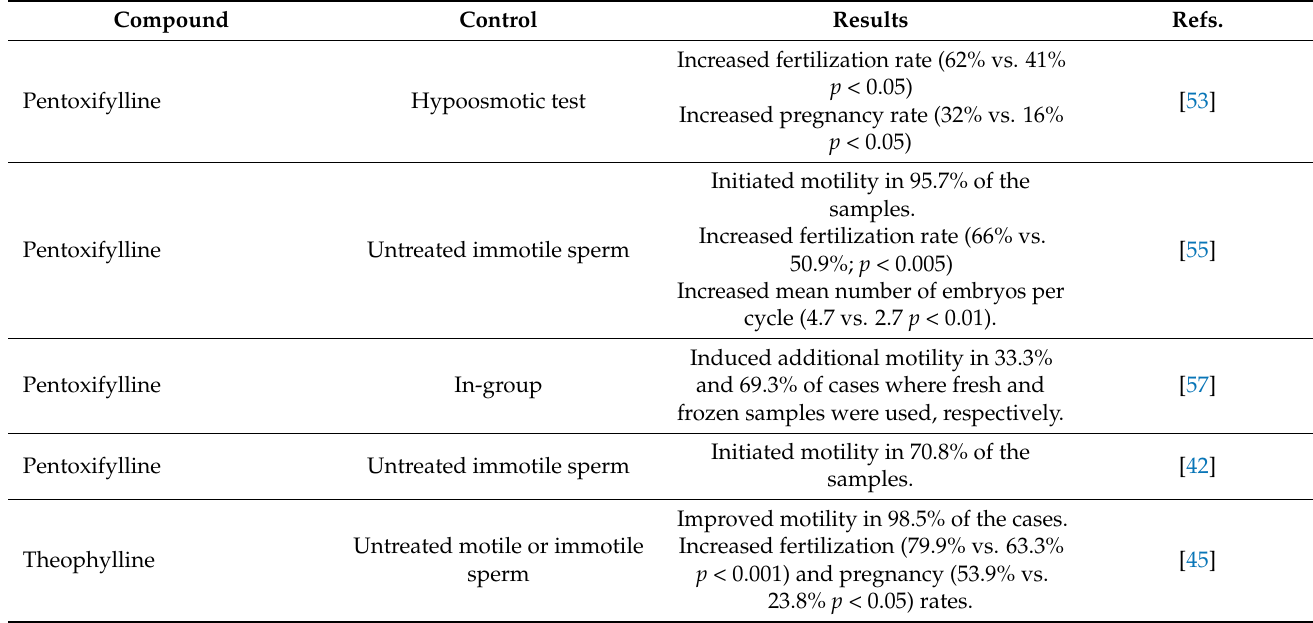
Table 2. Clinical results of motility enhancers for sperm recovery by